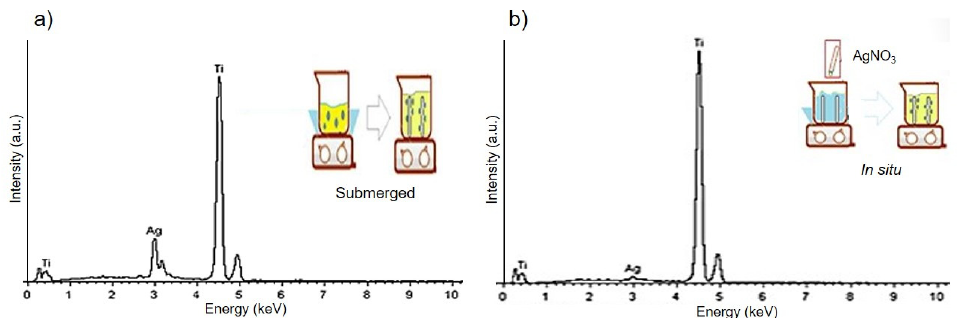
Figure 4. EDS spectra of the Ti surfaces coated with AgNPs using two routes of deposition ( a ) submerged reduction and ( b ) “in situ” reduction.